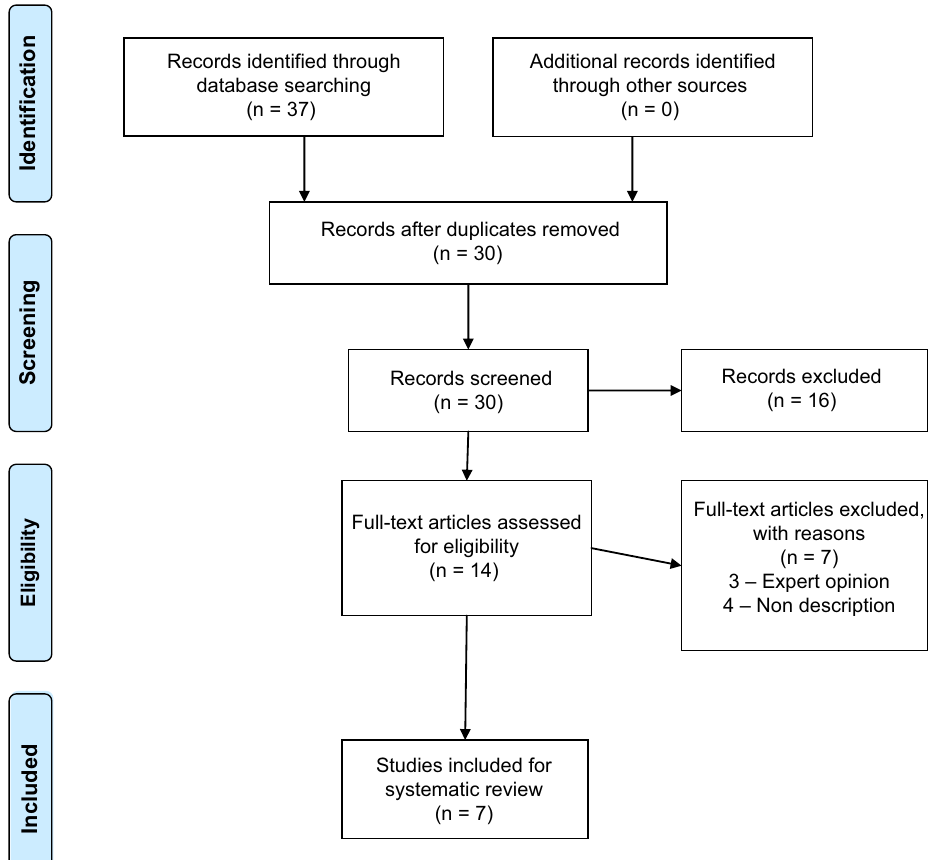
Figure 1. PRISMA 2009 flow